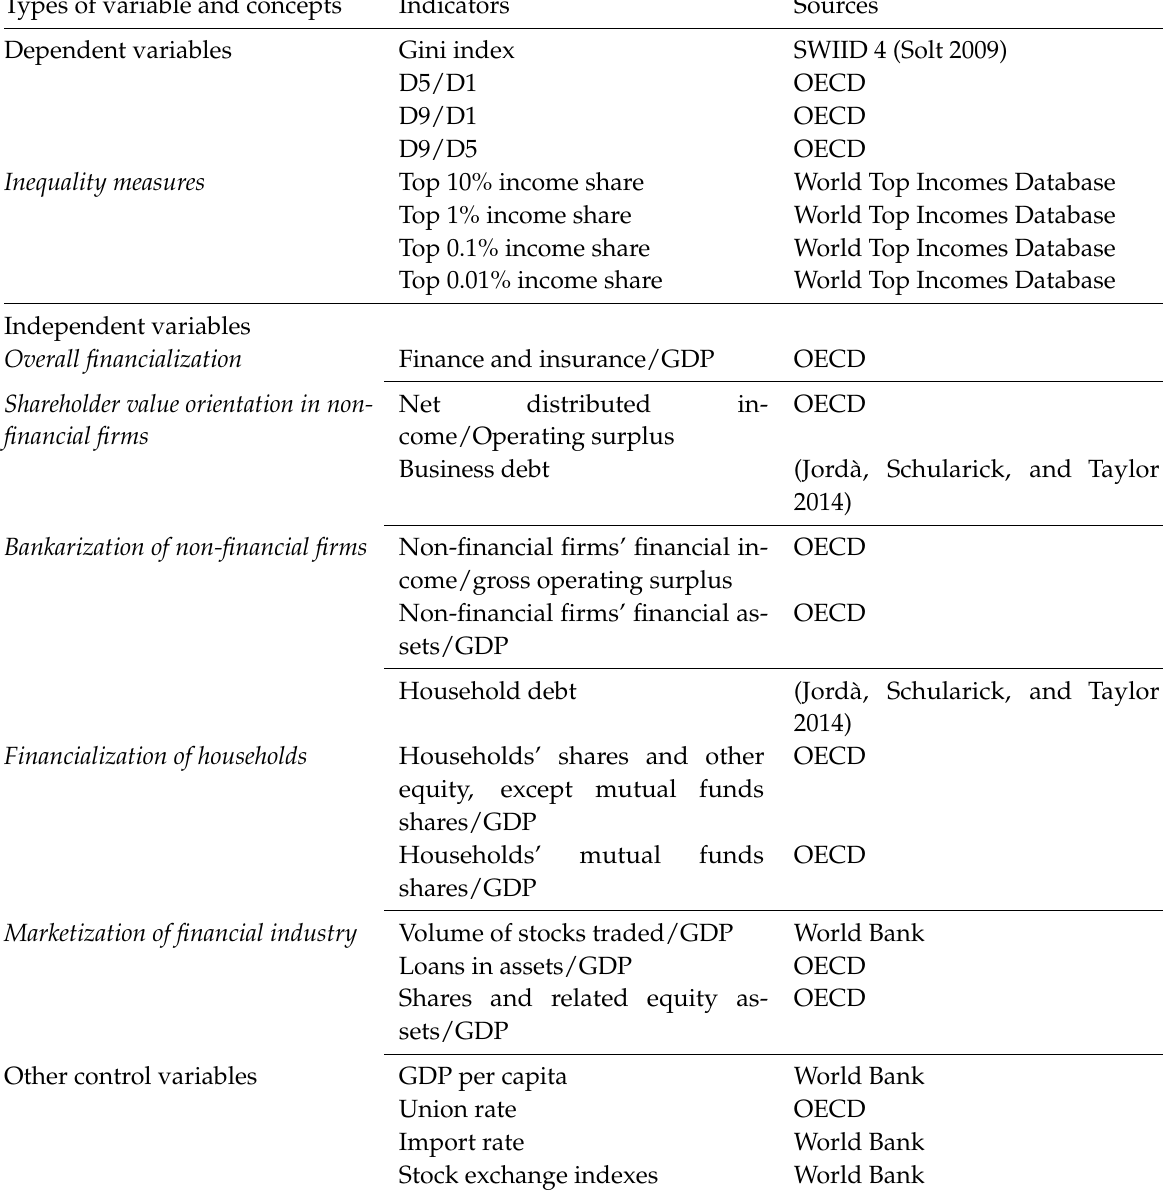
Table 1: Dependent, Independent, and Control Variables Types of variable and